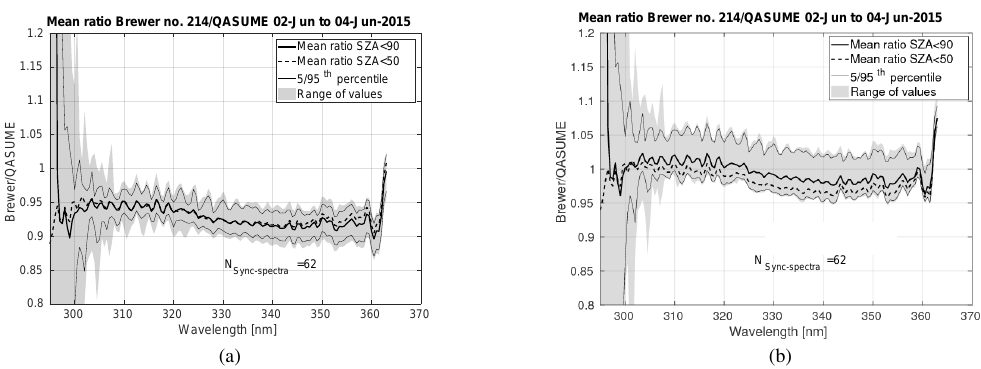
Figure 6. Mean ratio and range of measurements between Brewer no. 214 and QASUME irradiances for measurements done at SZA < 90 ◦ and SZA < 50 ◦ in the comparison campaign in Huelva during 2–4 June 2015. The 5th and 95th percentile and the range of the values, and the number of QASUME synchronised spectra (N_sync_spectra) are shown. (a) No cosine error correction was applied to the data. (b) The data was cosine error corrected.